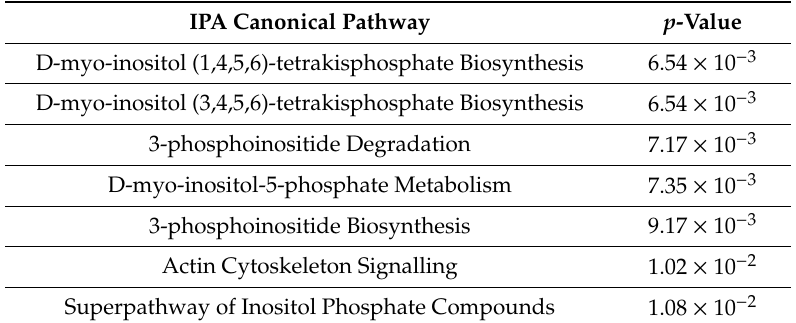
Table 5. Canonical pathway analysis: pathways likely to be altered by SSH3